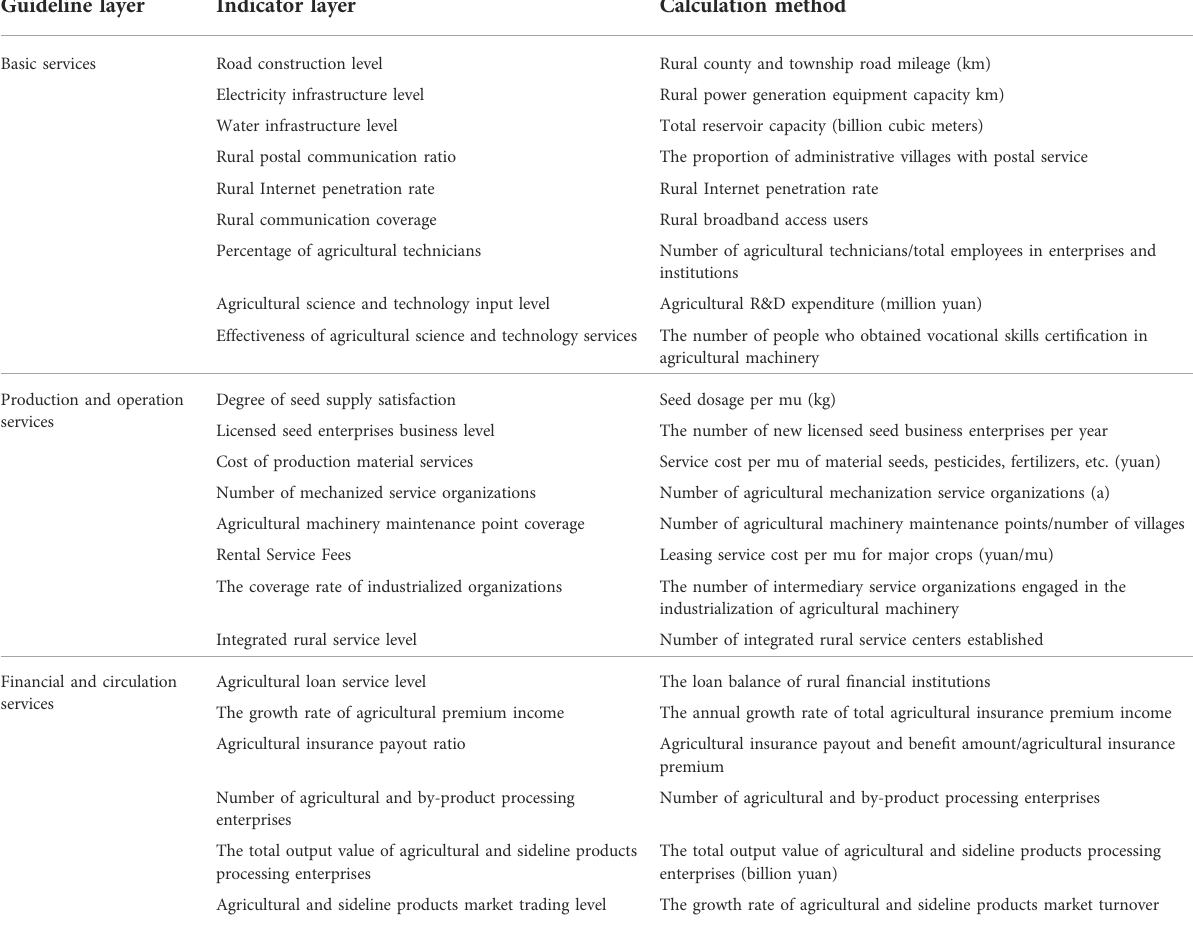
TABLE 2 Measurement indicators and methods of agricultural socialization service